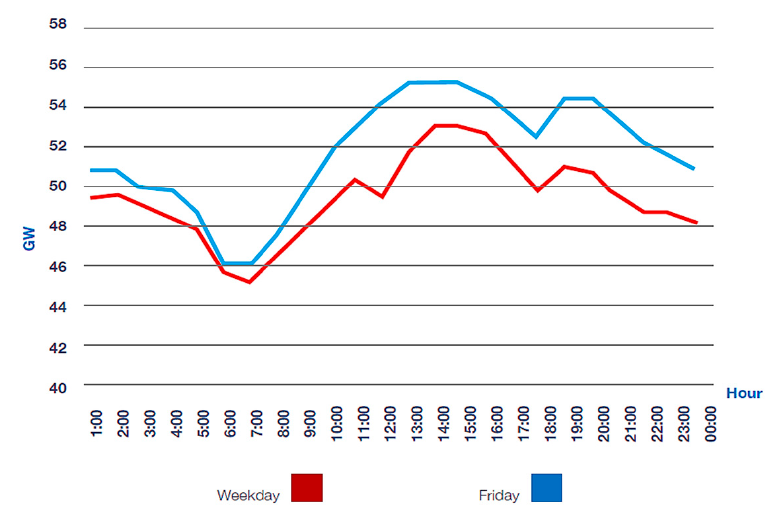
Figure 1. Kingdom of Saudi Arabia’s (KSA) typical daily electricity load curve during summer [4] .